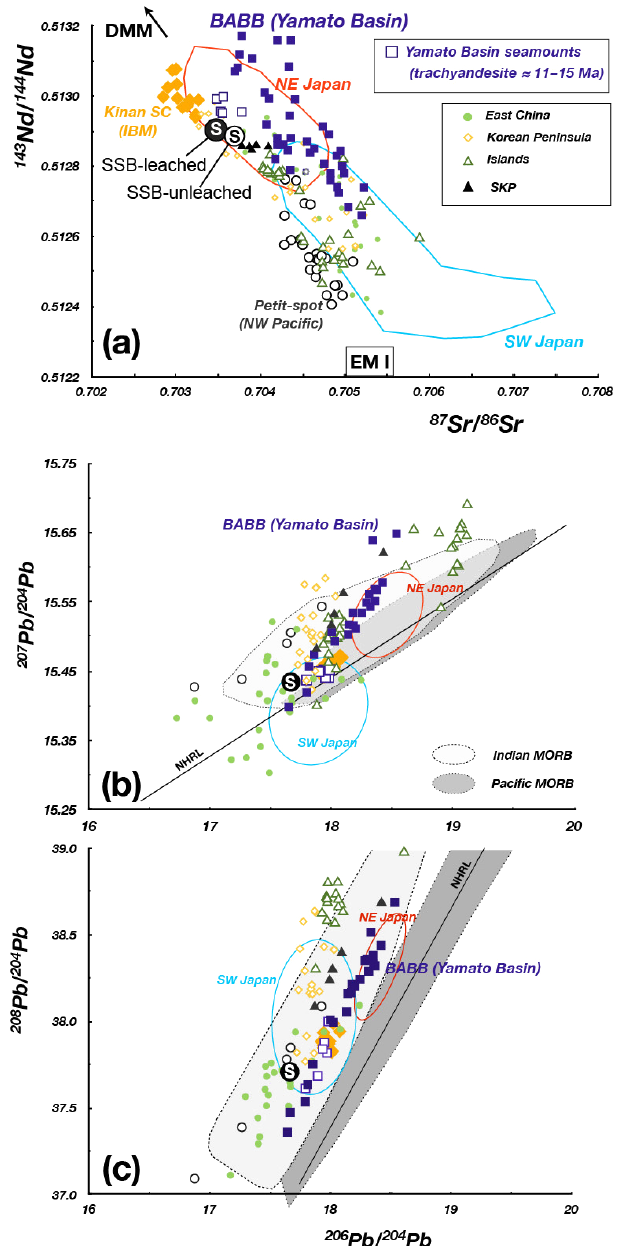
Figure 6. Nd–Sr–Pb isotopic compositions of the SSM basalt (leached: black circle annotated with S; unleached: white circle annotated with S). (a) Sr–Nd isotopic plot. (b) 206 Pb / 204 Pb vs. 207 Pb / 204 Pb. (c) 206 Pb / 204 Pb vs. 208 Pb / 204 Pb. Reference data and data fields were taken from Basu et al. (1991), Tatsumoto and Nakamura (1991), Cousens and Allan (1992), Nohda et al. (1992), Pouclet et al. (1994), Lee et al. (2001), Park et al. (2005), Choi et al. (2006), Ishizuka et al. (2009), Machida et al. (2009, 2015), and Hirahara et al. (2015). Indian and Pacific MORB fields in (b) and (c) are from Miyazaki et al. (2015). The Northern Hemisphere Ref- erence Line (NHRL) is from Hart (1984).